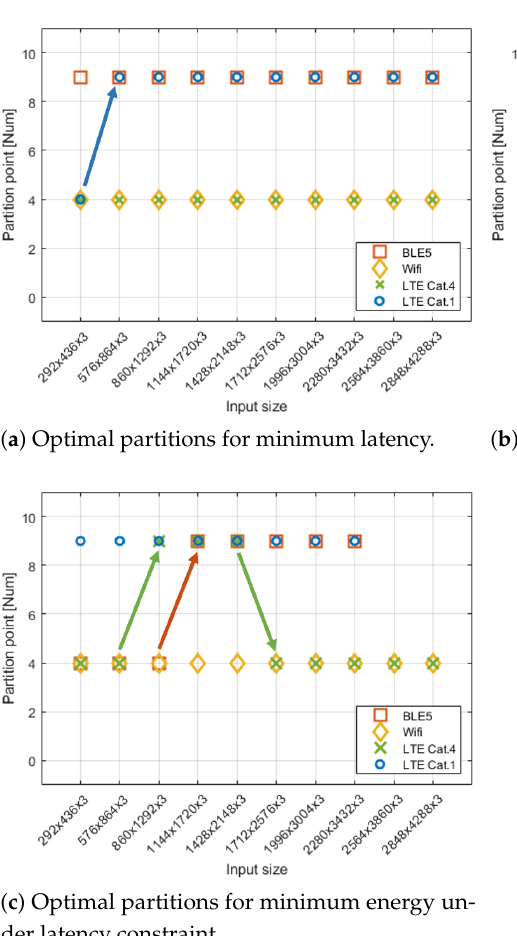
Figure 11. Partitioning solutions for three different objective functions, four different communication protocols and ten different image